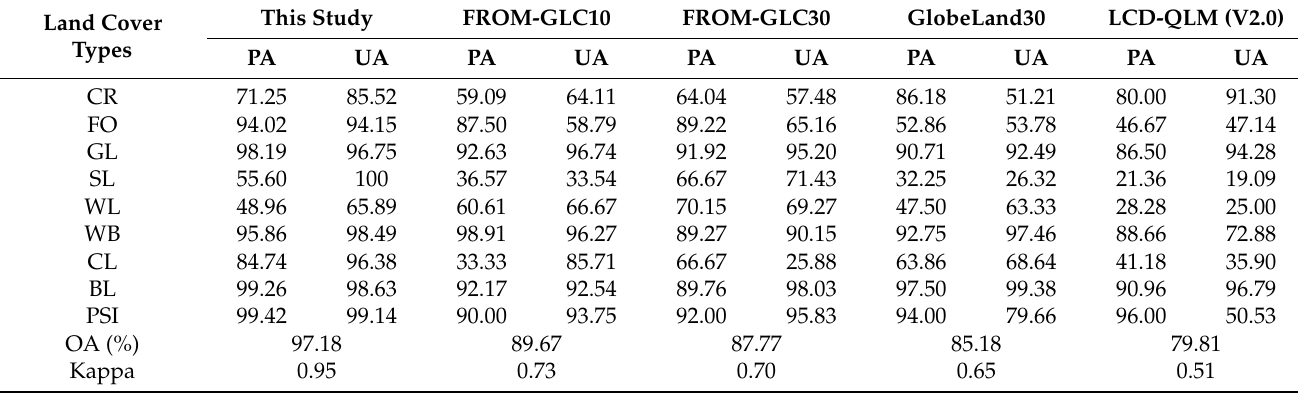
Table 5. Accuracy comparison (%) of the classification results obtained in this study with the existing land cover